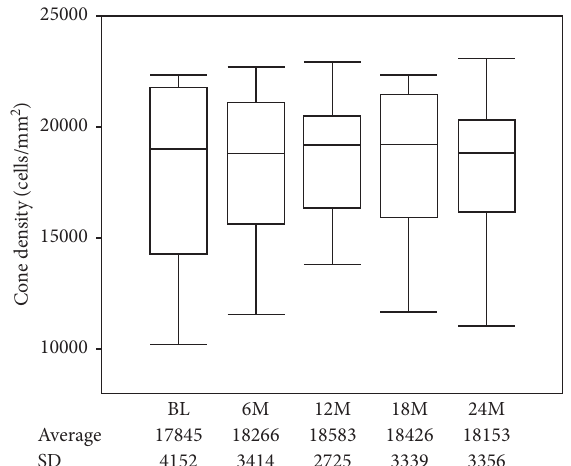
Figure 2: Among 9 patients whose cumulative dose was over 200g in 2 years, the mean cone density showed no significant change at 6, 12, 18, and 24 months compared with baseline ( P � 0 . 381, P � 0 . 380, P � 0 . 281, and P � 0 . 534, respectively) ( n �